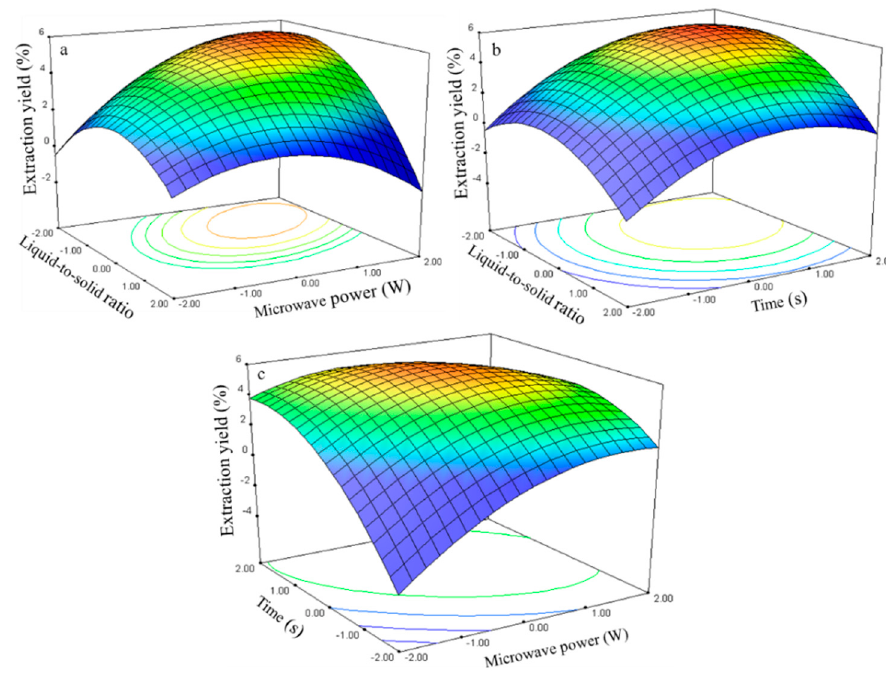
Figure 8. Response surface plots for the effects of: ( a ) liquid-to-solid ratio/power ( b ) liquid-to-solid/time ( c ) power/time on the extraction yield of quercetin.